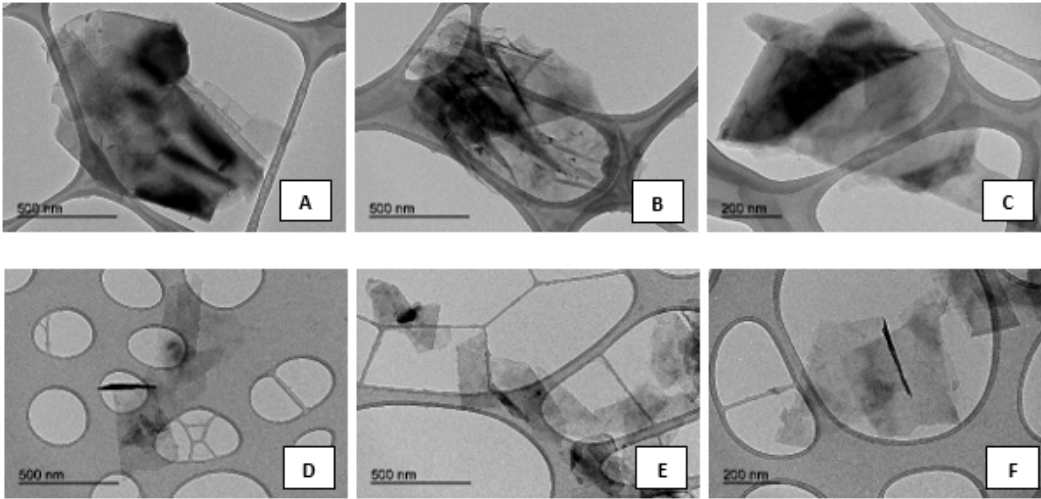
Figure 2. TEM images with different magnification for ( A – C ) micrographite (MG) and ( D – F ) graphene nanosheets (GNS) samples.